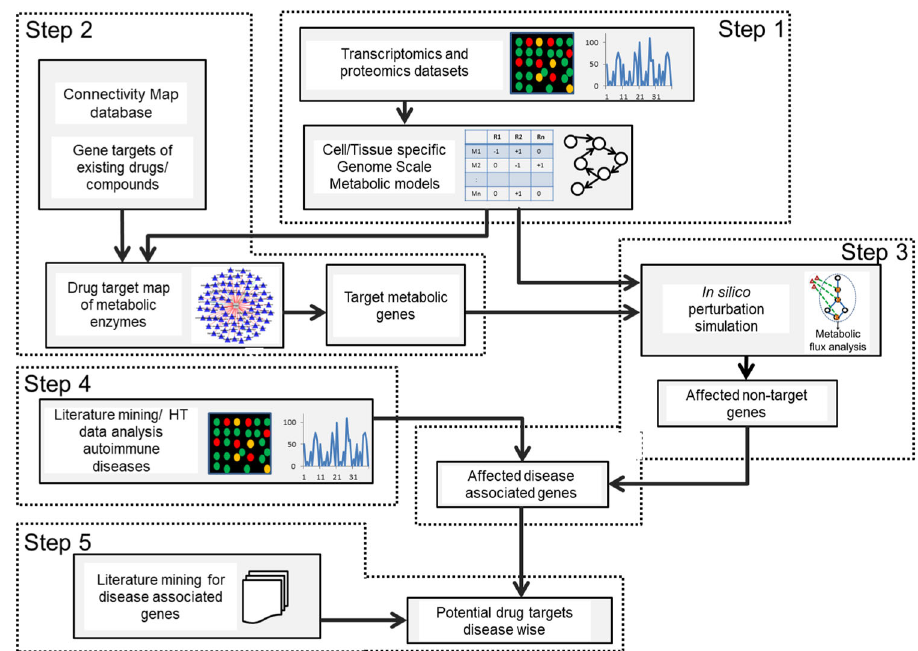
Fig. 1 Integrative approach for the identi fi cation of potential metabolic drug targets. The computational approach comprised of fi ve major steps: (1) Construction of metabolic models using integrated transcriptomics and proteomics data, (2) Identi fi cation of metabolic genes that are targets for existing drugs/compounds, (3) In silico inhibition of targets of existing drugs to identify affected reactions, (4) Identi fi cation of differentially expressed genes (DEGs) in autoimmune diseases and their integration with fl ux ratios (Flux perturbed /Flux WT ), and (5) Validation with literature and prediction of new